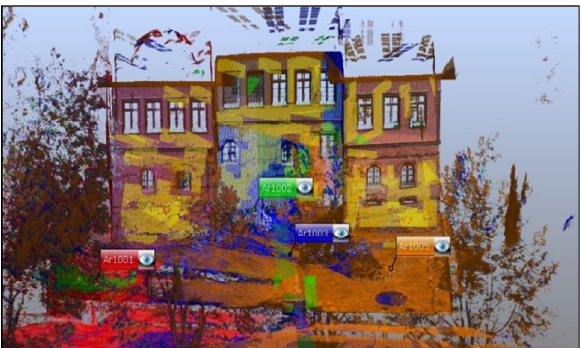
Figure 10. Scanned Skoutaris Mansion in 3D and surrounding